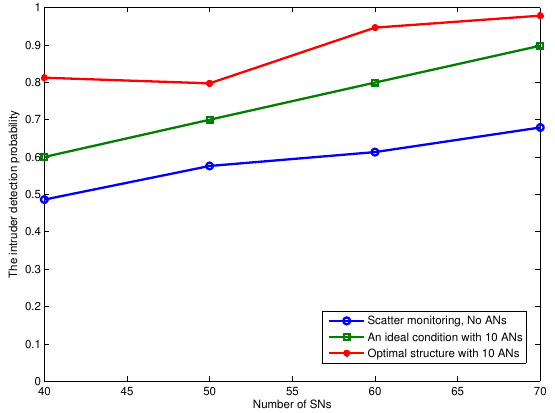
Figure 14. The intruder detection probability γ varies with different SNs’ number in different conditions.